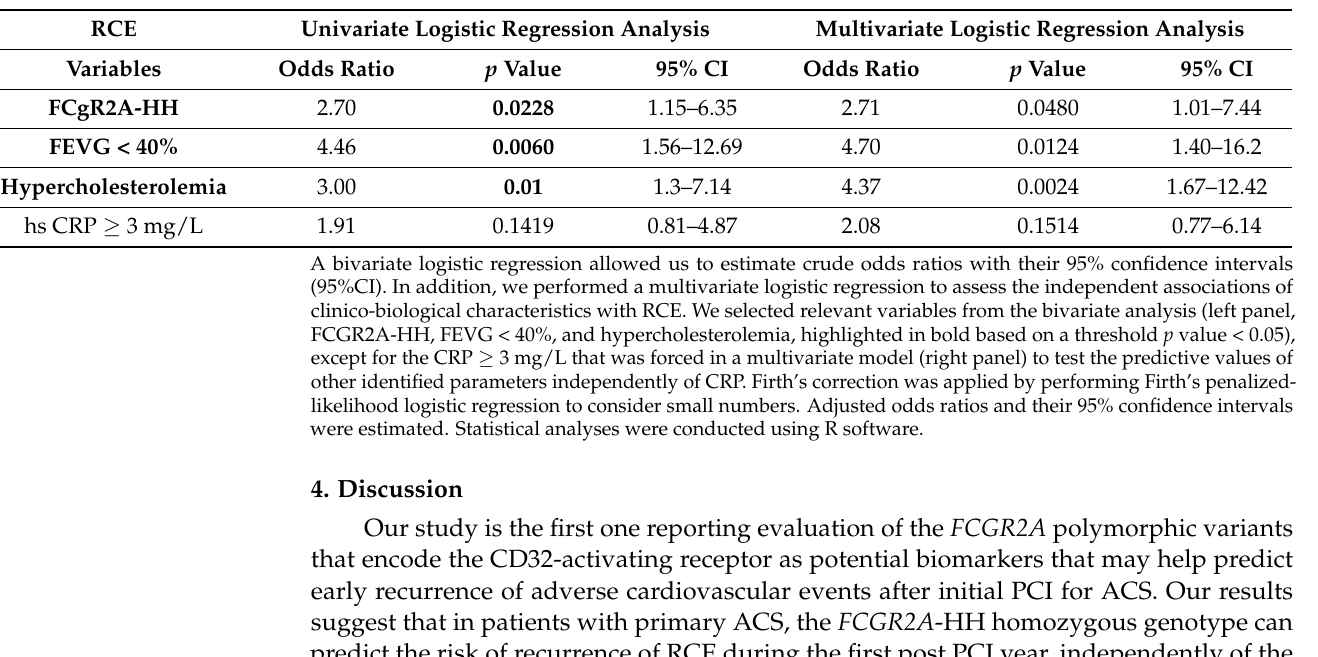
Figure 5. Distribution of FCGR2A rs1801274 and FCGR3A Rs 396,991 genetic allelic variants associated with development of RCE during the first year after initial ACS diagnosis. ( A ) Distribution of the FCGR2A genotype in the whole cohort of patients with ACS (all patients) subdivided into patients who developed RCE and those who remained RCE free (no RCE). HH, HR, and RR refer to the homozygous or heterozygous combinations of FCGR2A allelic variants at the extracellular amino acid position 131: arginine (R) or histidine (H). Frequencies in patient groups were analyzed in reference to those in healthy control groups. ( B ) FF, VF, and VV refer to the combinations of FCGR3A allelic variants at position 158: valine (V) or phenylalanine (F). FF indicates the homozygous phenylalanine genotype; VV indicates the homozygous alanine genotype; VF indicates the heterozygous valine/phenylalanine genotype. RCE, recurrence of cardiovascular events; CTL, healthy control individuals. Table 3. Multivariate analysis of variables associated with high RCE risk.